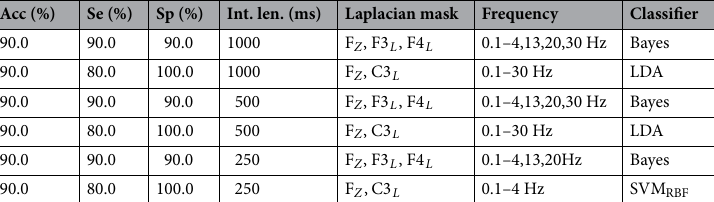
Table 1. Classification results using validation set for different combinations of values. Shown are the best results when using interval length of 250 ms, 500 ms and 1000 ms, different Laplacian masks, upper frequency band of 4 Hz, 13 Hz, 20 Hz and 30 Hz, and several classifiers (Linear Discriminant Analysis (LDA), Quadratic Discriminant Analysis (QDA), Bayes and Support Vector Machine (SVM) with radial basis function (RBF)). Subscripted L in channel designations of Laplacian masks indicates large Laplacian